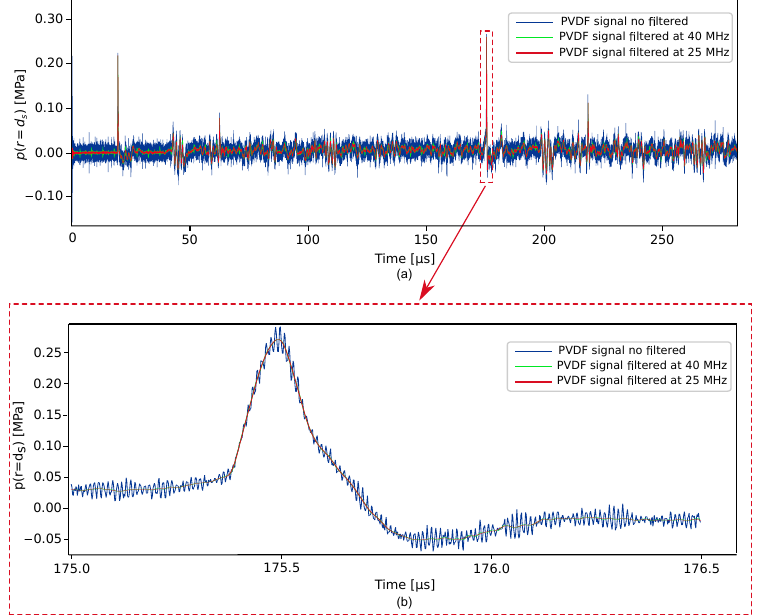
Figure A1. ( a ) The comparison of different filtered signals from the PVDF sensor for γ = 36.4, the blue signal curve is the PVDF signal before filtering, the green curve is the PVDF signal filtered at 40MHz and the red curve is the PVDF signal filtered at 25MHz. ( b ) Zoom of the peak pressure caused by the bubble